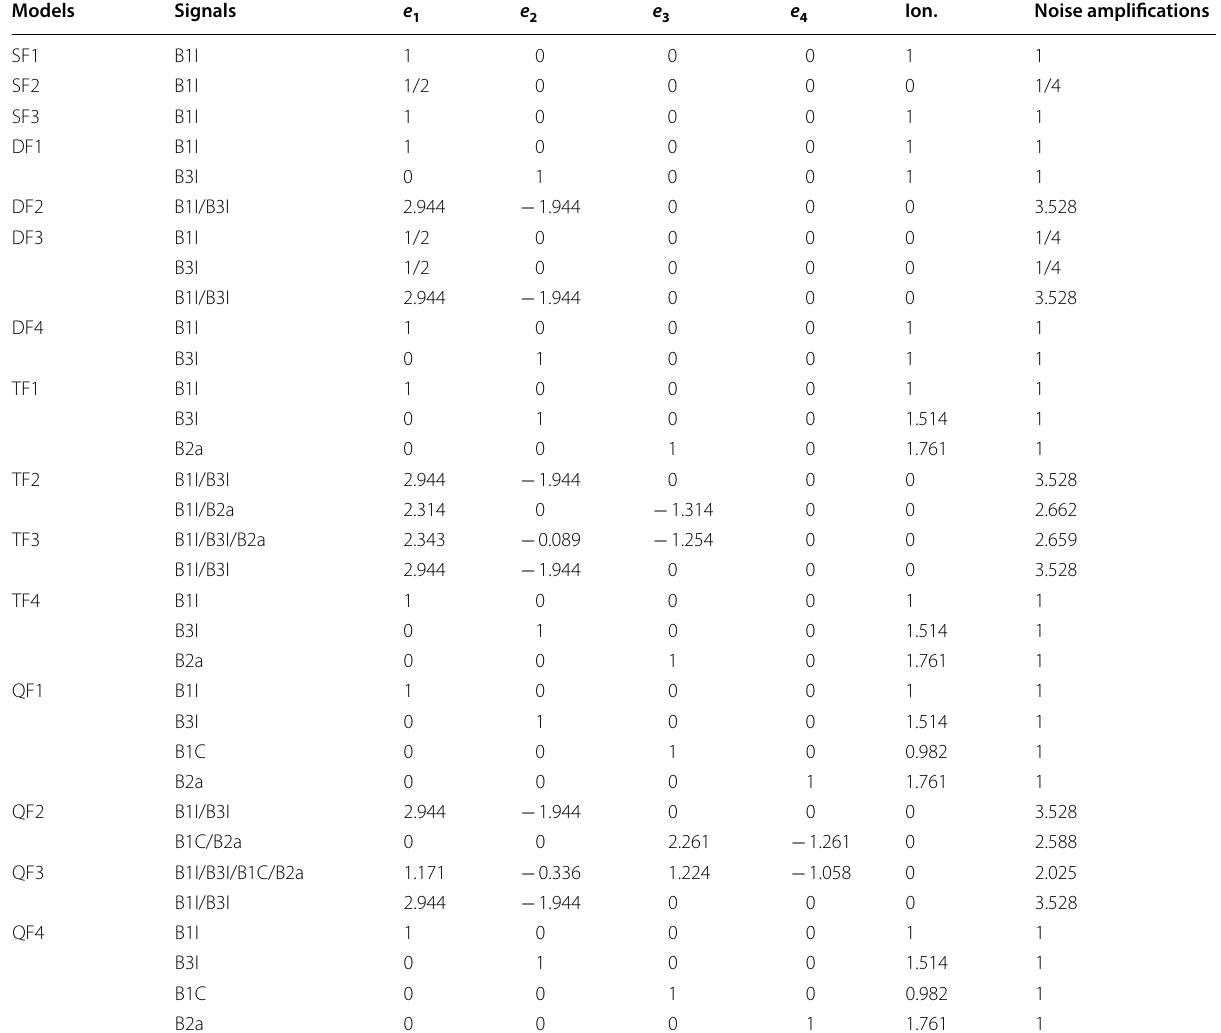
Table 2 Characteristics of the BDS PPP models